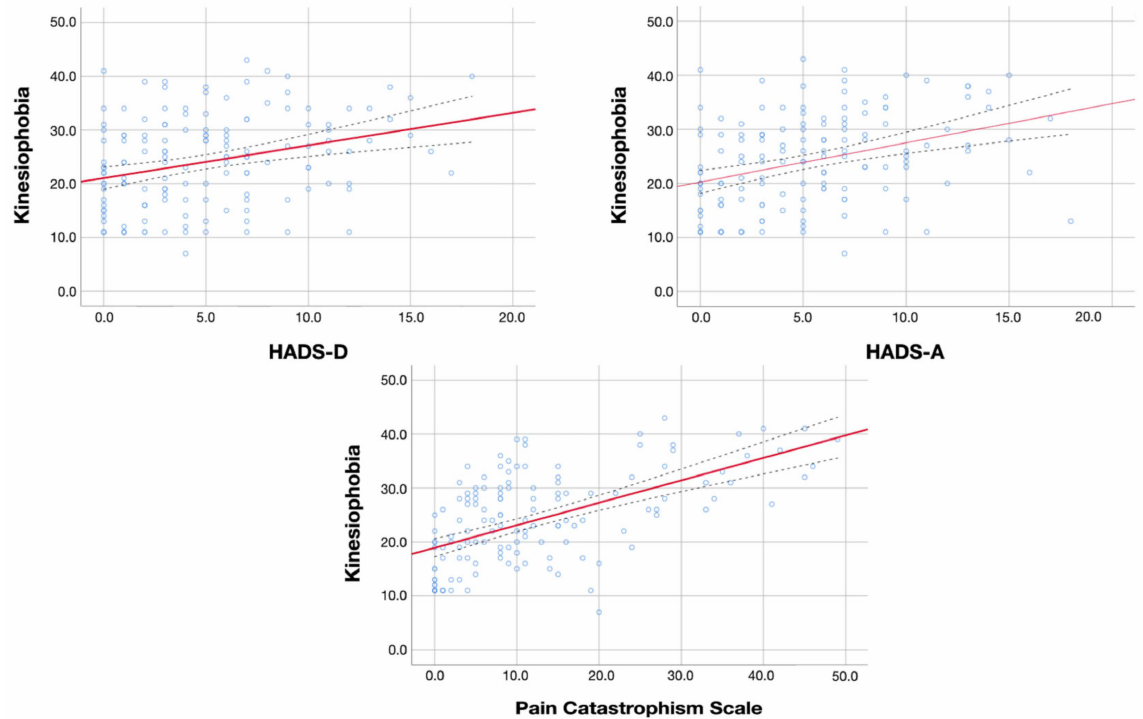
Figure 1. Association between kinesiophobia and psychological variables: anxiety (HADS-A), de- pression (HADS-D) and catastrophism. Red line represents the correlation coefficient whereas blue dot lines represent the confidence intervals of the coefficient.